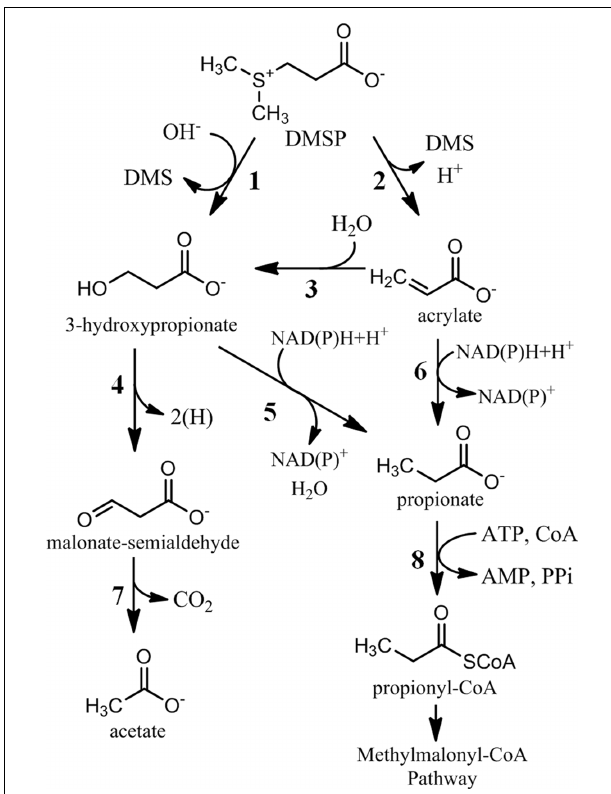
FIGURE 3 | Dimethylsulfoniopropionate cleavage pathways leading to central carbon metabolism. Reactions 5 and 6 may be coenzyme-A mediated and would therefore bypass reaction 8. 1, DMSP-cleavage enzyme (DddD); 2, DMSP lyase (DddL, DddP, DddQ, DddY, DddW, E.C. 4.4.1.3); 3, acrylate hydratase; 4, 3-hydroxypropionate dehydrogenase; 5, 3-hydroxypropionate reductase; 6, acrylate reductase (1.3.99.3); 7, malonate semialdehyde dehydrogenase/decarboxylase (E.C. 1.2.1.18); 8, propionate-CoA ligase (PrpE, E.C.